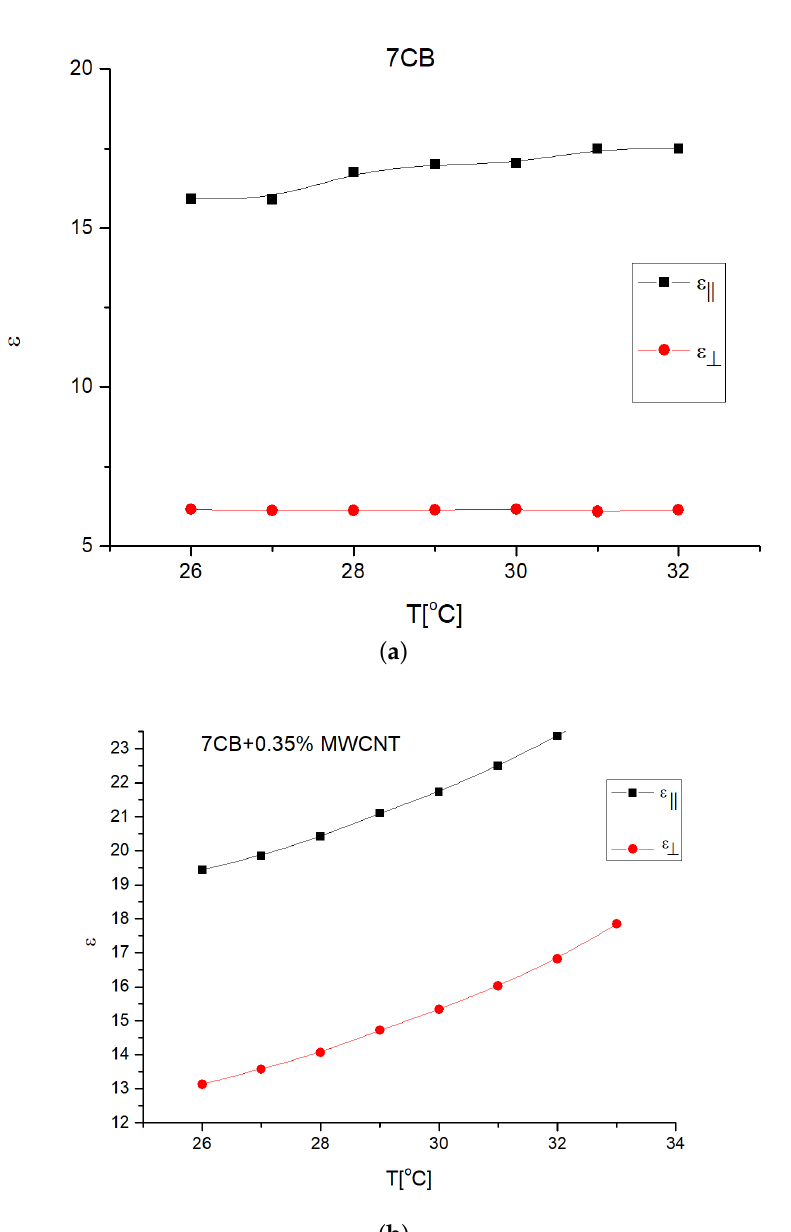
Figure 7. Parallel and perpendicular permittivities for ( a ) 7CB and ( b ) 7CB + 0.36%